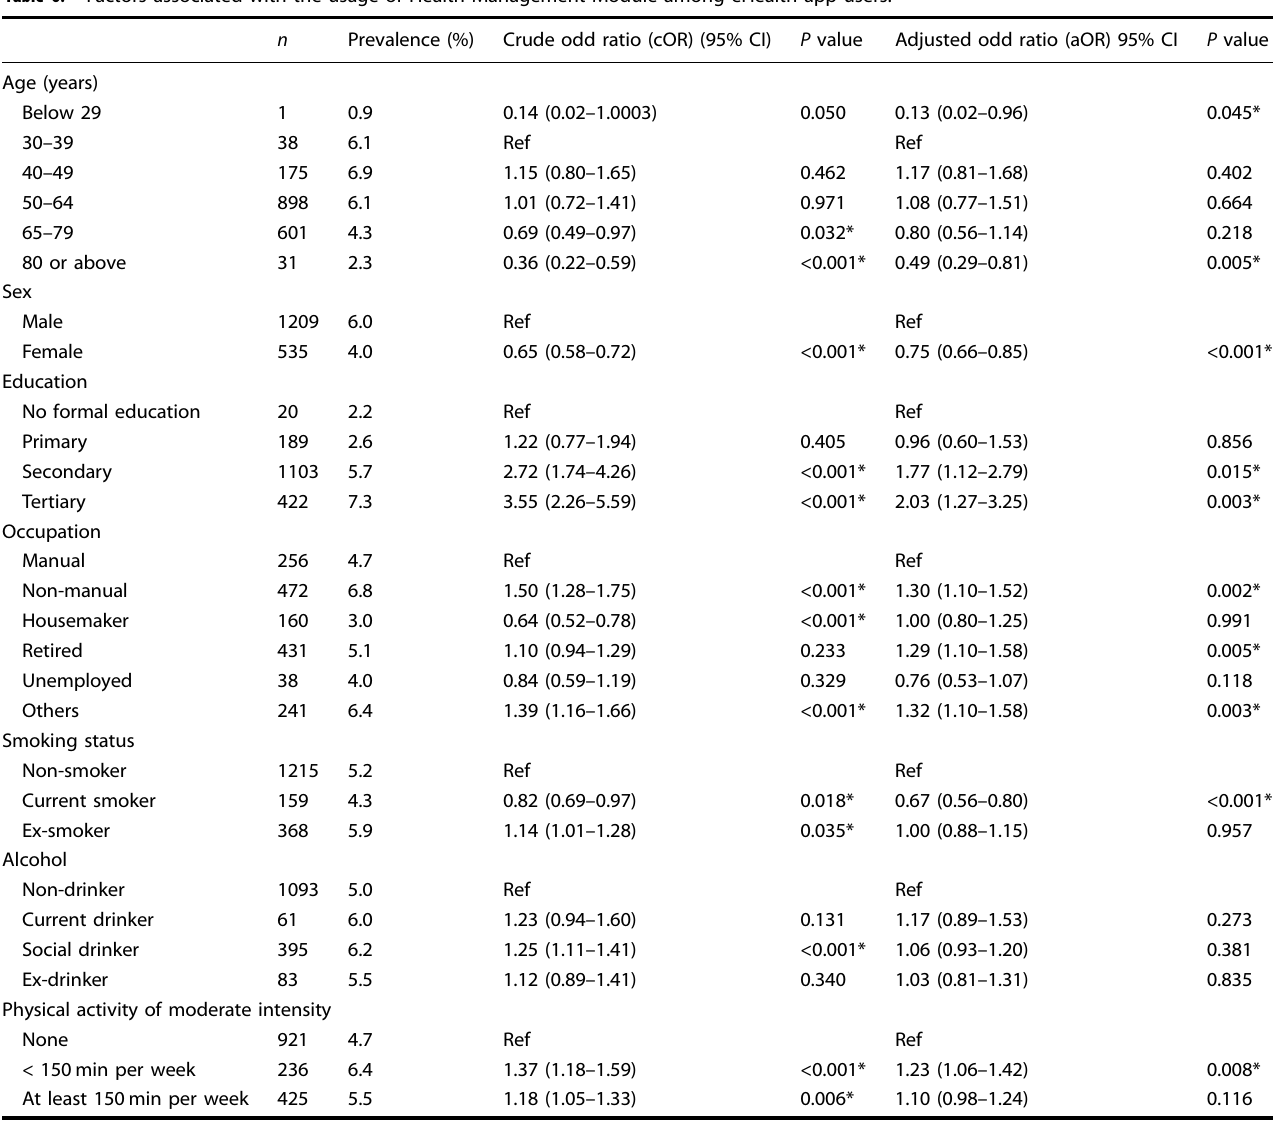
Table 6. Factors associated with the usage of Health Management Module among eHealth app